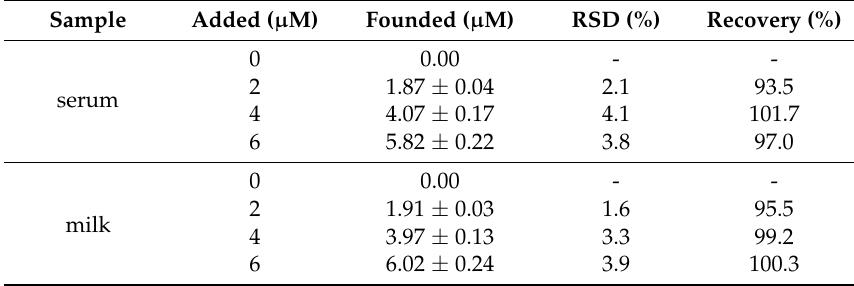
Figure 6. Fluorescent spectra of R123@CP5@Au-NPs in the presence of L-carnitine and other interferences ( A ). The relative fluorescence intensity of (F-F 0 )/F 0 and the F 0 and F are the fluorescence intensity without and with the presence of 10 µ M L-carnitine and 1 mM interferences ( B ). Table 1. Determination of the L-carnitine in human serum and milk samples.